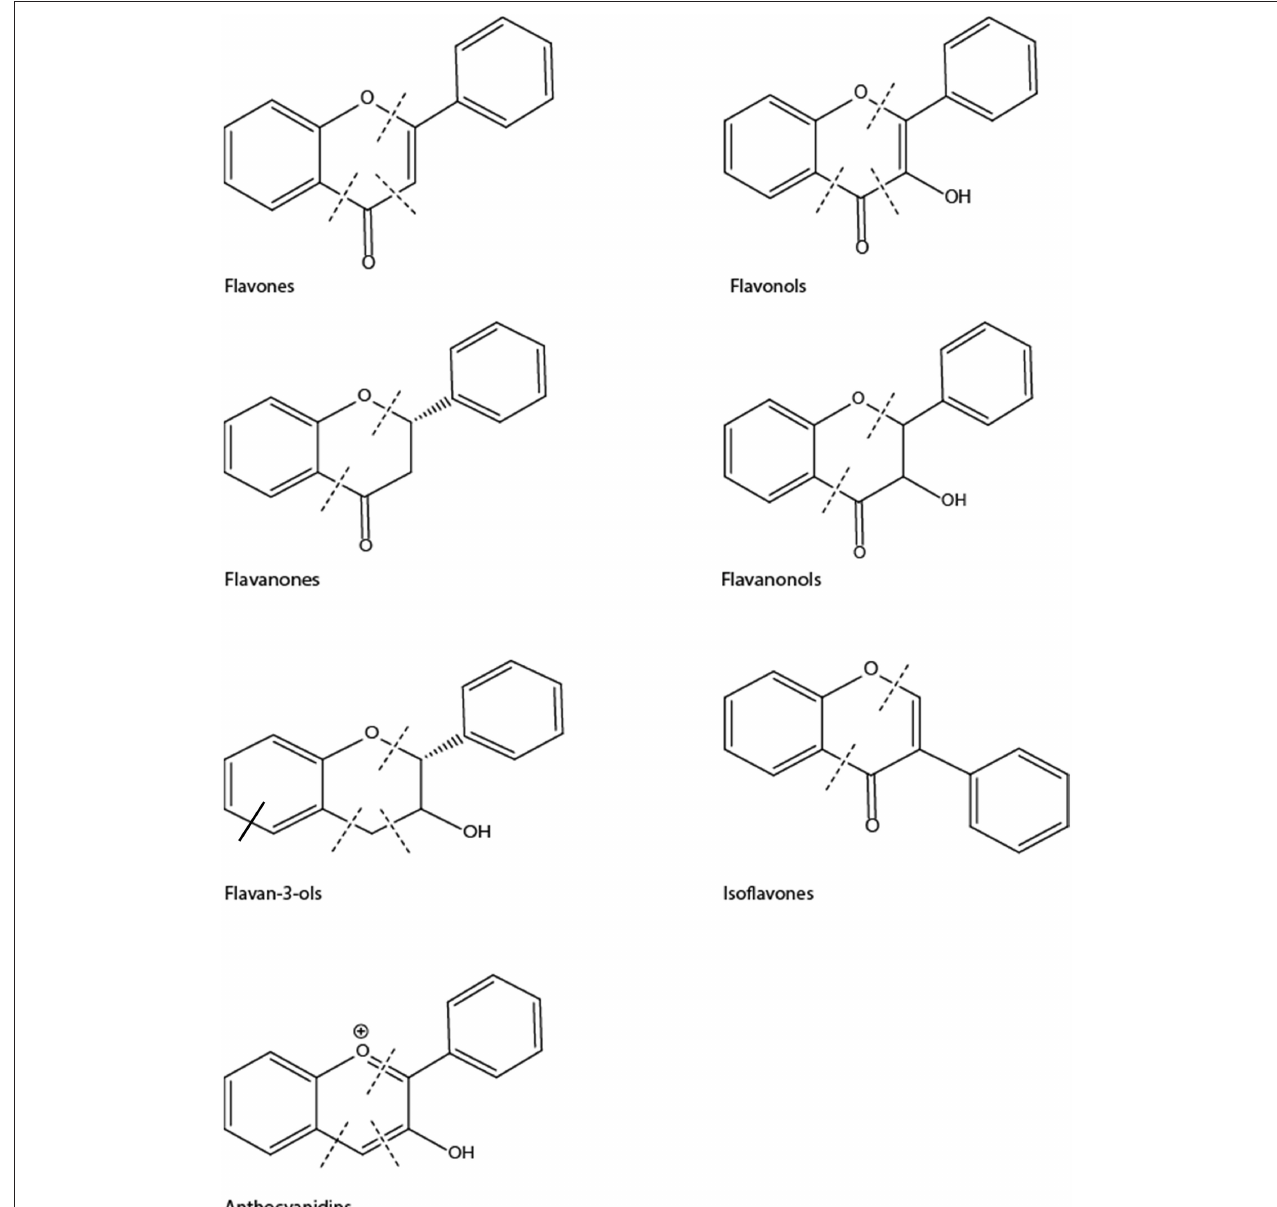
FIGURE 3 | Chemical structures of main classes of flavonoids showing positions of potential C-ring cleavage (——) or A-ring cleavage